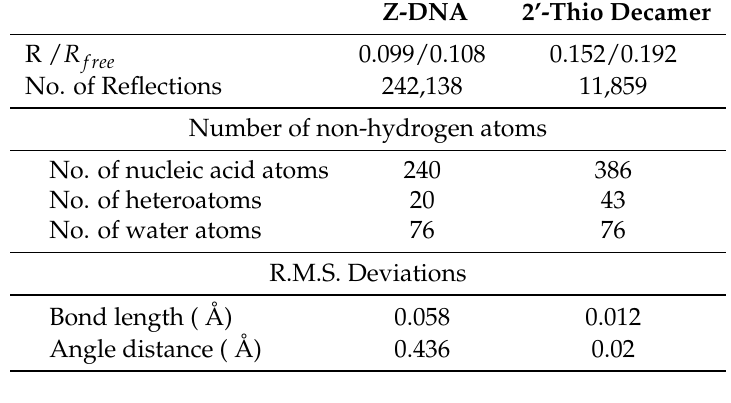
Table 4. Refinement statistics for Z-DNA and 2’-thio-modified DNA decamer refined using SHELXL.